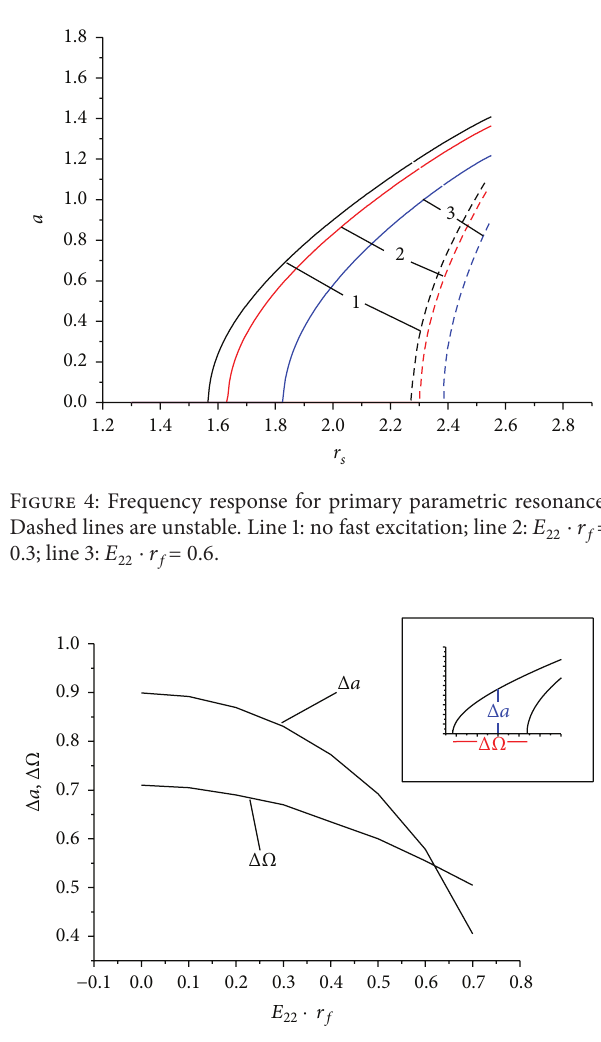
Figure 5: The amplitude Δ𝑎 at 𝑟 𝑠 = 2.0 and the width of the resonant region ΔΩ as functions of the fast excitation parameter 𝐸 22 ⋅ 𝑟 𝑓